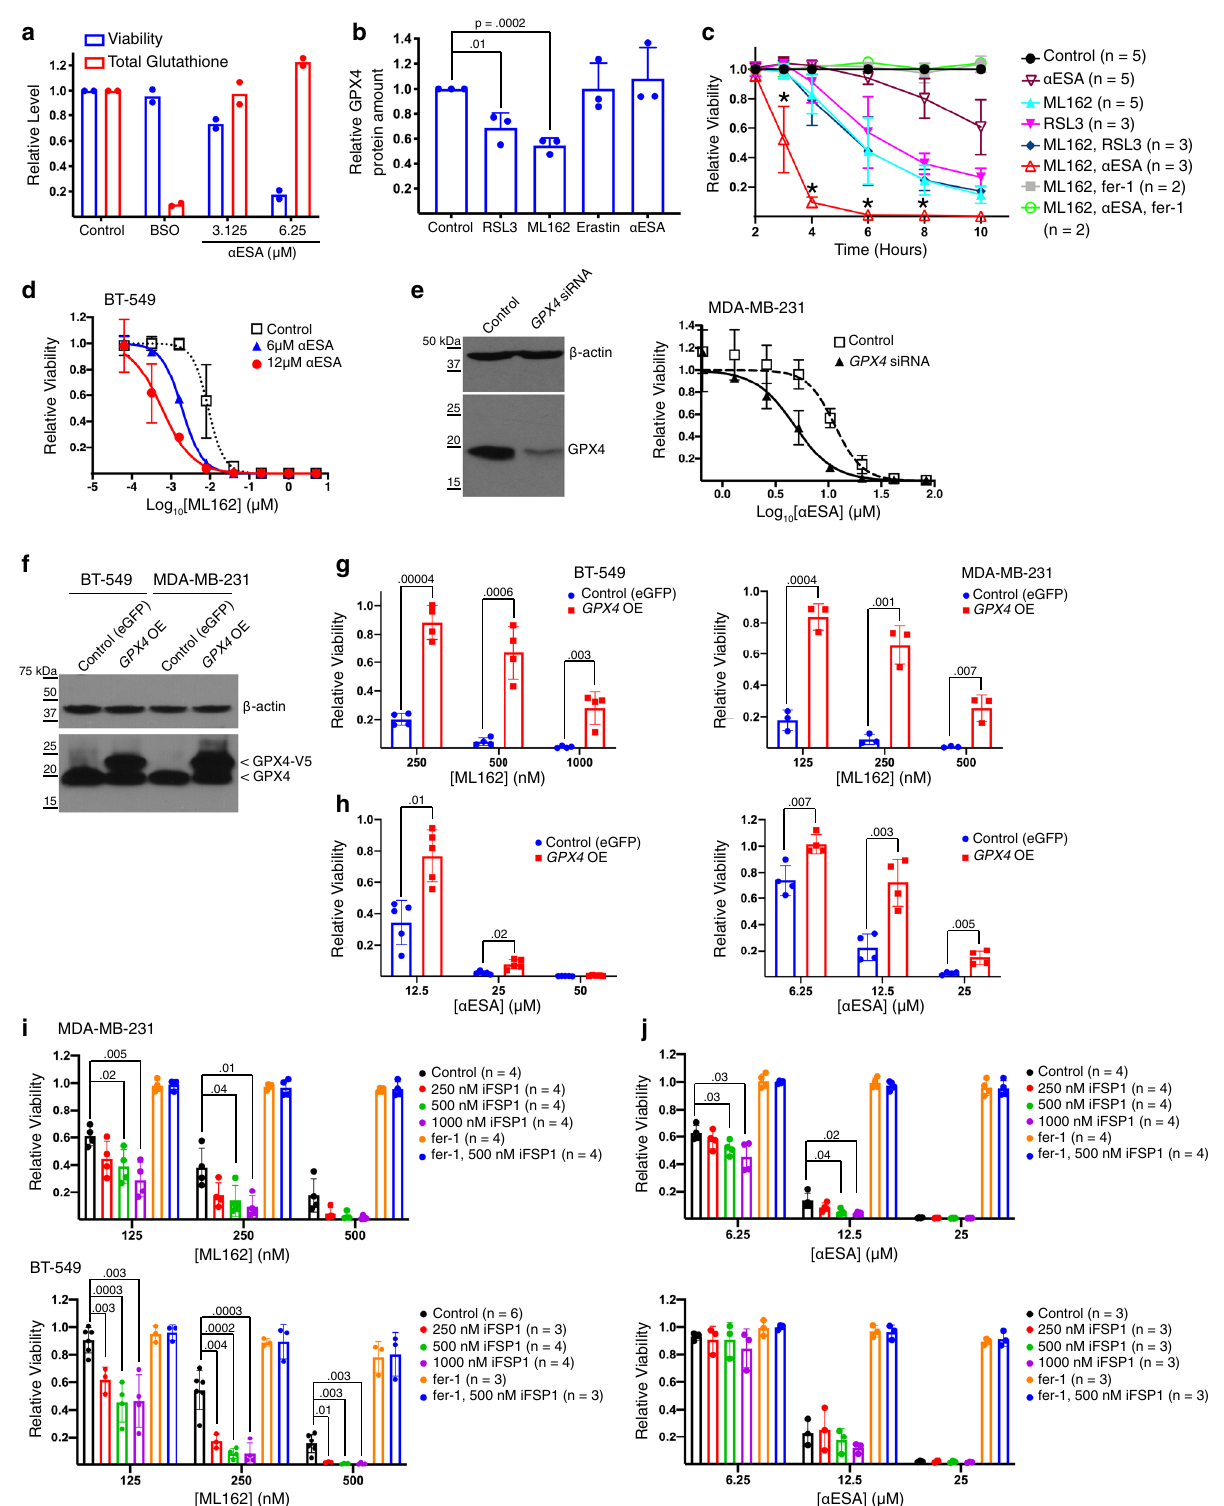
fi ndings demonstrate a role for ACSL1 in the incorporation of α ESA and other fatty acids into DAGs/TAGs, which could suggest a role for lipid droplets in α ESA-induced ferroptosis. α ESA triggers ACSL1-dependent increases in lipid hydroper- oxides . We next sought to characterize α ESA-induced lipid